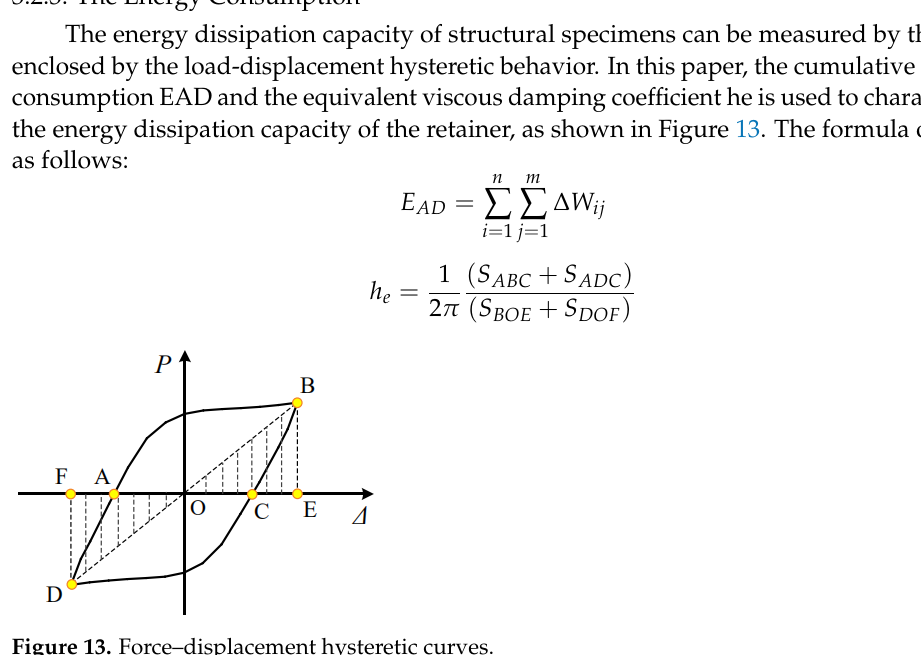
Figure 13. Force–displacement hysteretic Figure 13. Force – displacement hysteretic curves. EAD — the cumulative hysteretic energy consumption of structural specimens; i , j — the total number of loading levels and the number of cycles loaded per level; Δ Wij — hysteretic energy dissipation when the cycles is j and the load level is i .